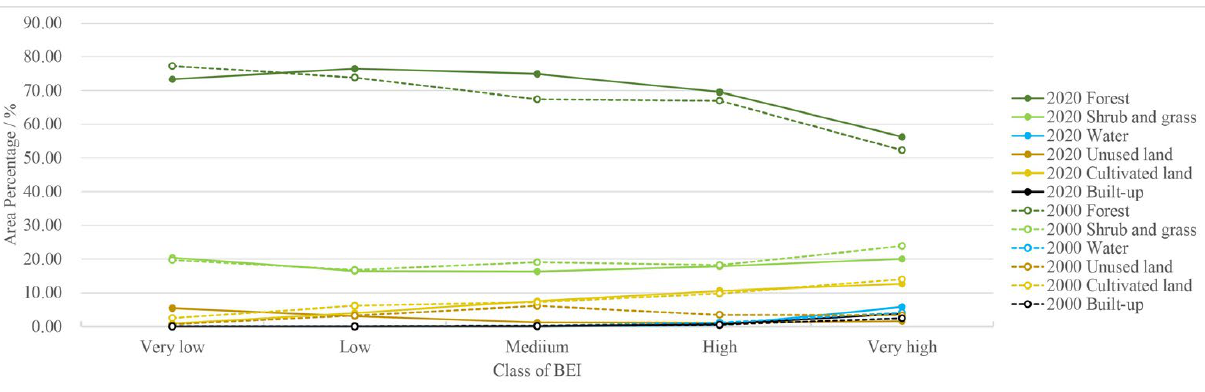
Figure 6. Landscape structure of different BEI areas.